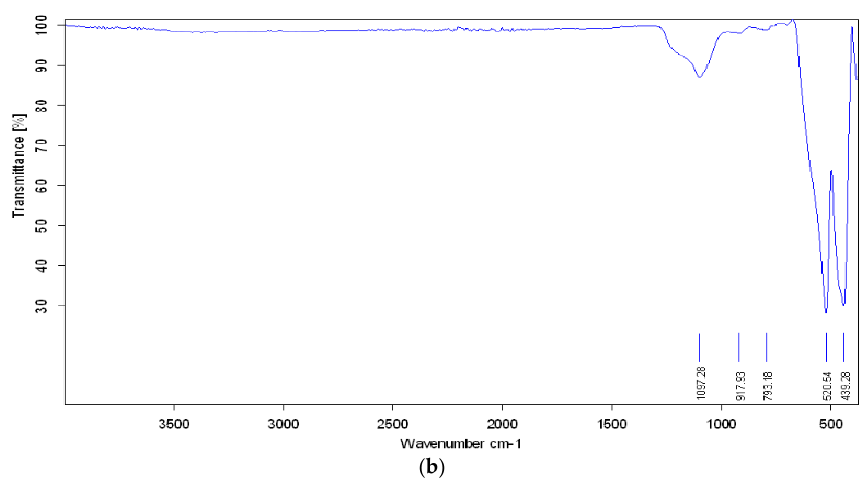
Figure 3. FT-IR spectra of ( a ) PANI/Fe 2 O 3 composites ( b ) pure Fe 2 O 3 .